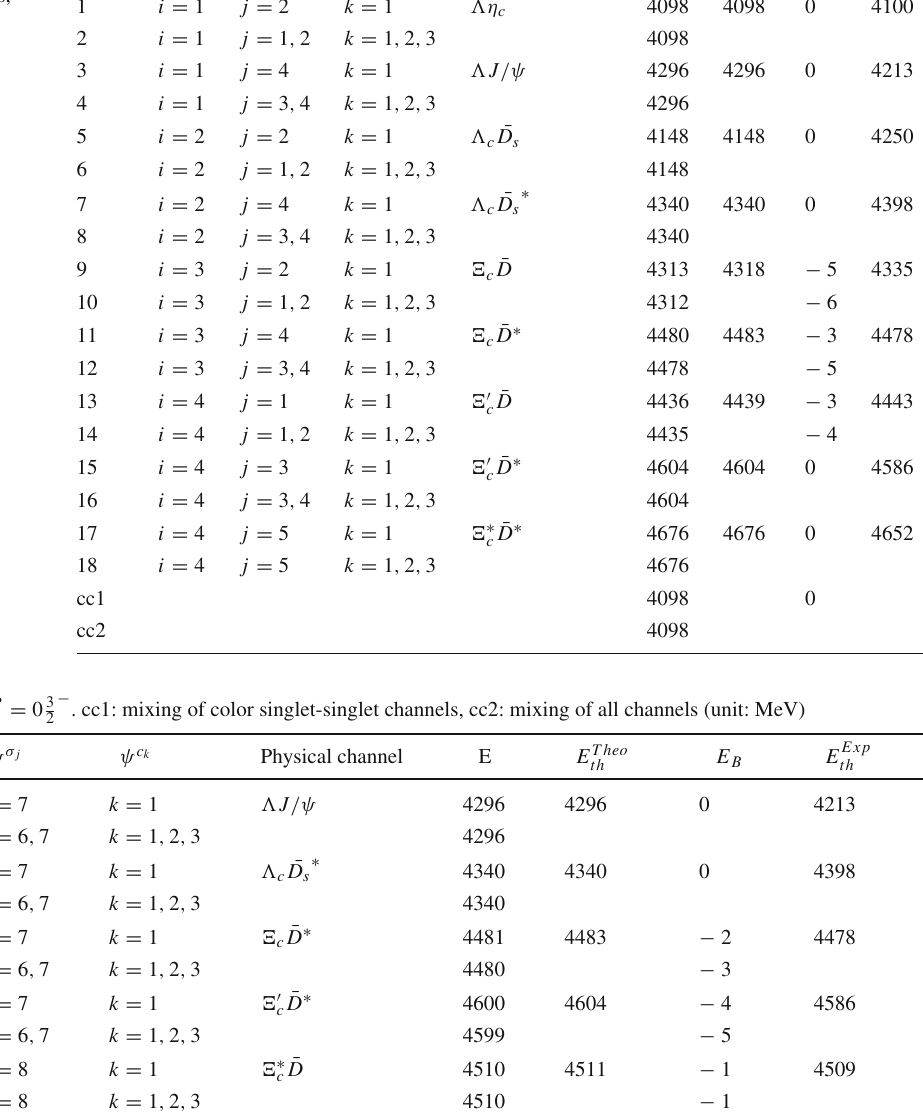
Table 3 The results for − I J P = 0 1 . cc1: mixing of 2 color singlet-singlet channels, cc2: mixing of all channels